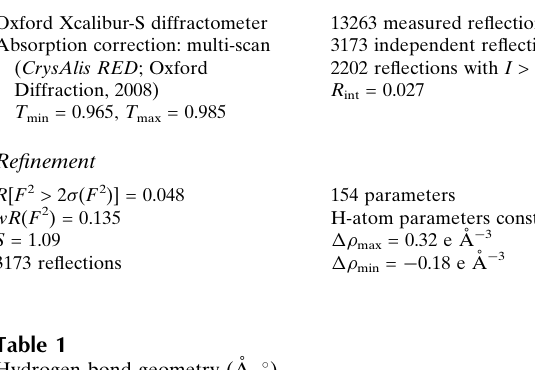
Hydrogen-bond geometry (A˚ , (cid:1)